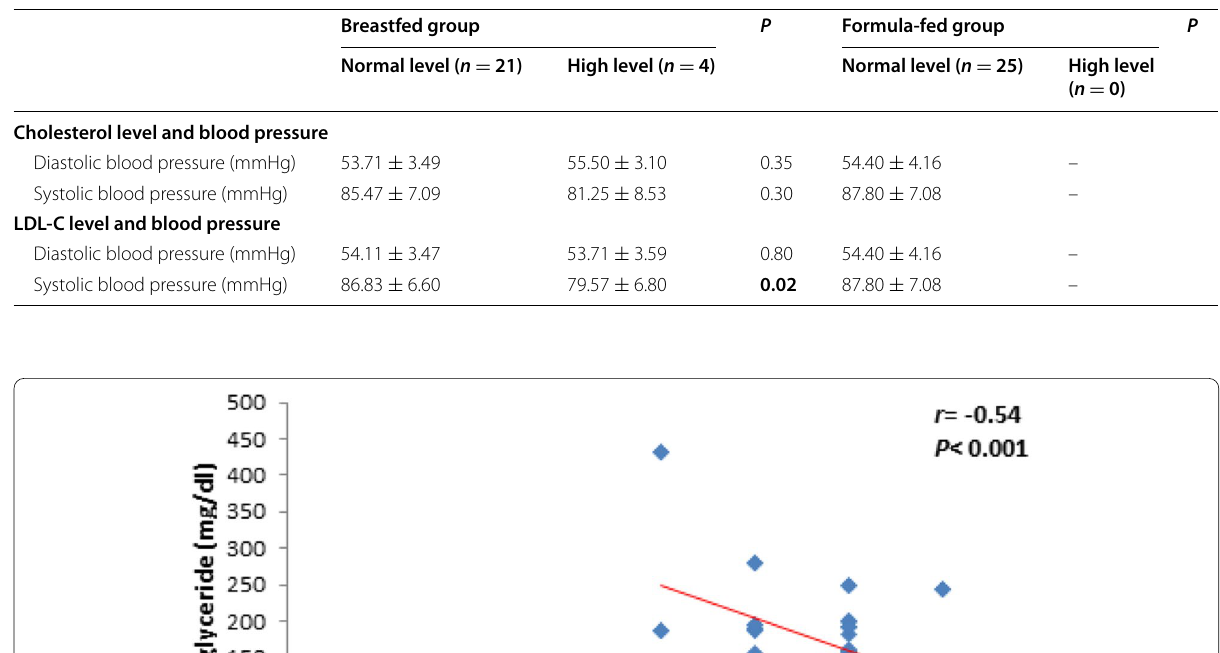
Table 3 Cholesterol and LDL‑C levels in relation to blood pressure and in each separate group